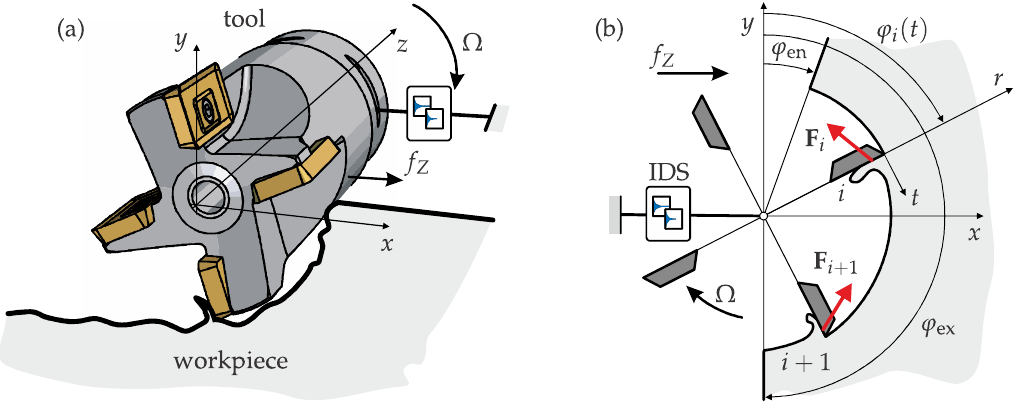
Figure 1. Sketch of the simple one-dimensional milling model is shown in ( a ), which can be simplified to a planar mechanical problem shown in ( b ). In this consideration, the IDS represents the dynamics originated from the measured impulse response function